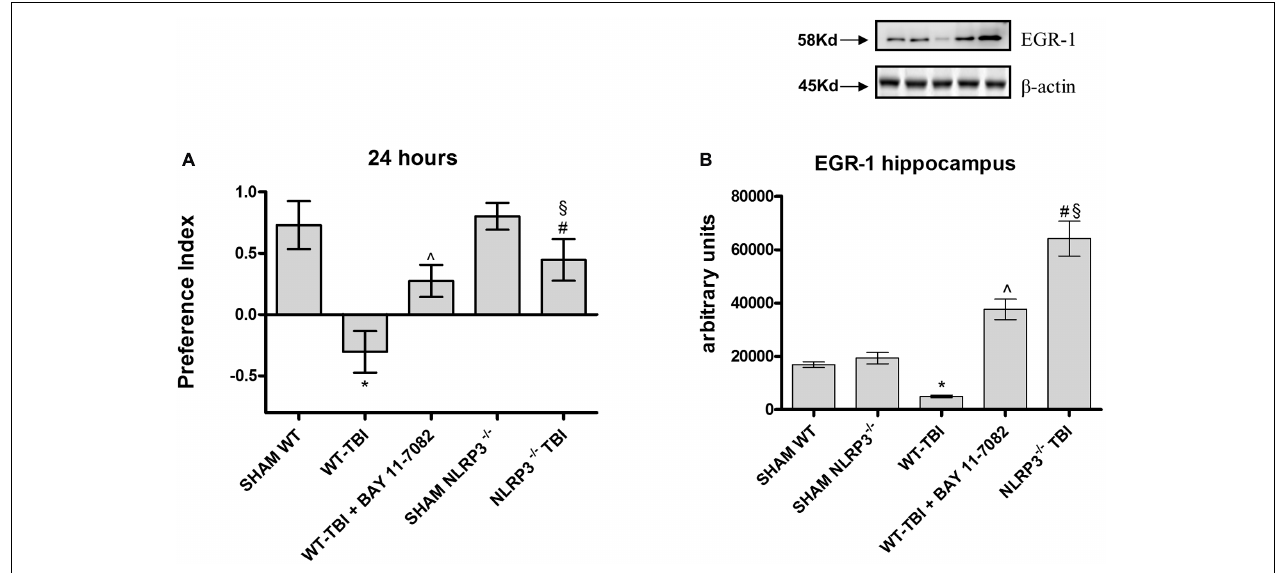
FIGURE 1 | The graph (A) represents the cumulative score obtained by the animals in the behavioral test 24 h after TBI. Representative western blot (B) of EGR-1 in the hippocampus of mice evaluated at 24 h. ∗ p < 0.05 vs Sham WT; ˆ p < 0.05 vs WT-TBI; # p < 0.05 vs Sham NLRP3 − / − ; § p < 0.05 vs WT-TBI. Each bar represents the mean and SD of seven animals.